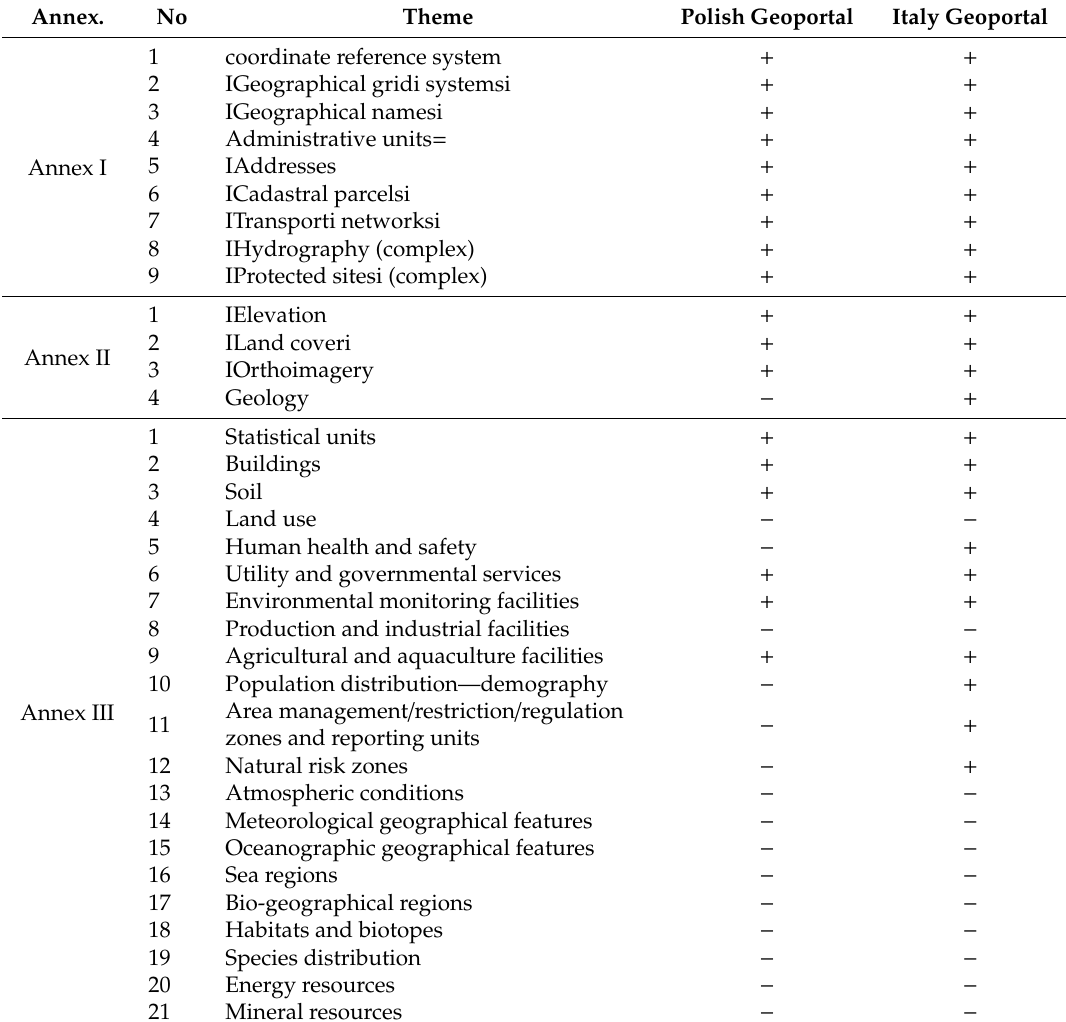
Table 2. Comparative analysis of ISO 19.100 implementation source: own study based on data from https: // inspire.ec.europa.eu / documents / summary-report-status-implementation-inspire-direct ive-eu and